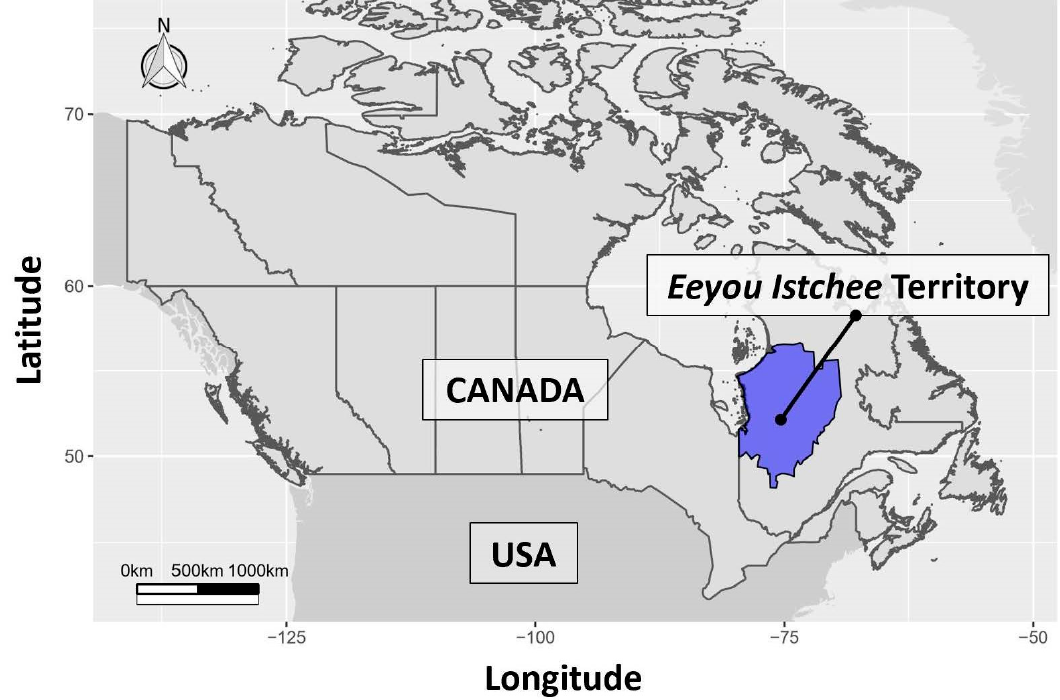
Figure 1. Map of the Eeyou Istchee Territory, Quebec, Canada.